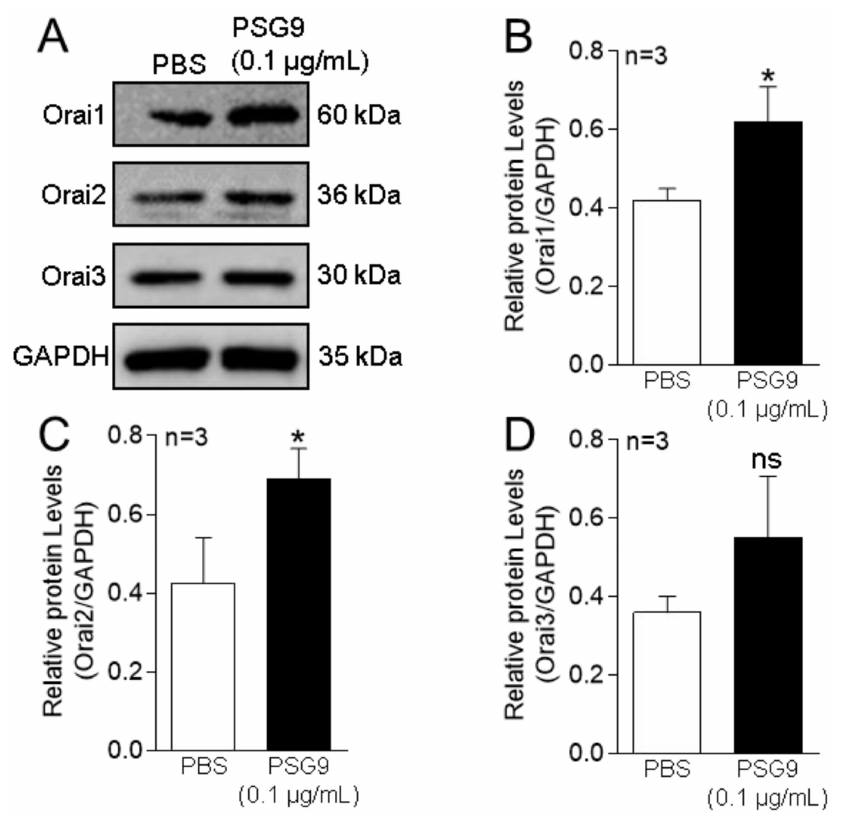
Figure 2. Effect of PSG9 on Orais expression in human umbilical vein endothelial cells (HUVECs). ( A – D ) Representative Western blot images ( A ) and summary data ( B – D ) showing Orai1, Orai2, and Orai3 expression levels after application of phosphate-buffered saline (PBS) or 0.1 µ g/mL PSG9 for 24 h in HUVECs. Values are shown as the mean ± SEM ( n = 3 as indicated). * p < 0.05 compared with PBS; ns, no significant